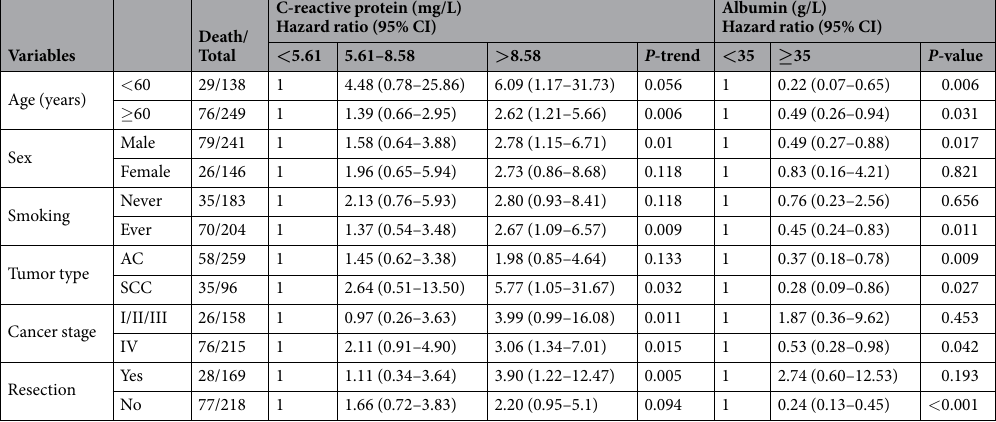
Table 4. COX proportional hazards regression stratified models of death and C-reactive protein, albumin. CI, confidence interval; AC, adenocarcinoma; SCC, squamous cell carcinoma. Model includes age at baseline interview, sex, body mass index, family history of cancer, patient history of chronic obstructive pulmonary disease, smoking status and drinking habit, tumor type, cancer stage, treatment, history of chronic liver disease and white blood cell count. Note: Exclude stratification factor when the model was